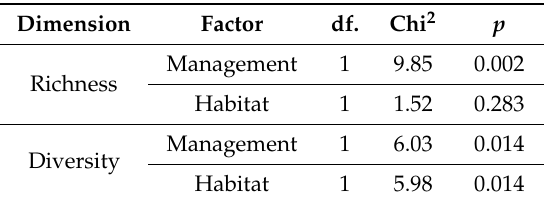
Table 1. Likelihood ratio test of linear mixed-model for taxa richness and diversity (Shannon diversity). Habitat (meadow vs. orchard) and management intensity (extensive vs. intensive) were tested separately. The region was implemented as a random factor nested in the season to account for both spatial and temporal autocorrelation.